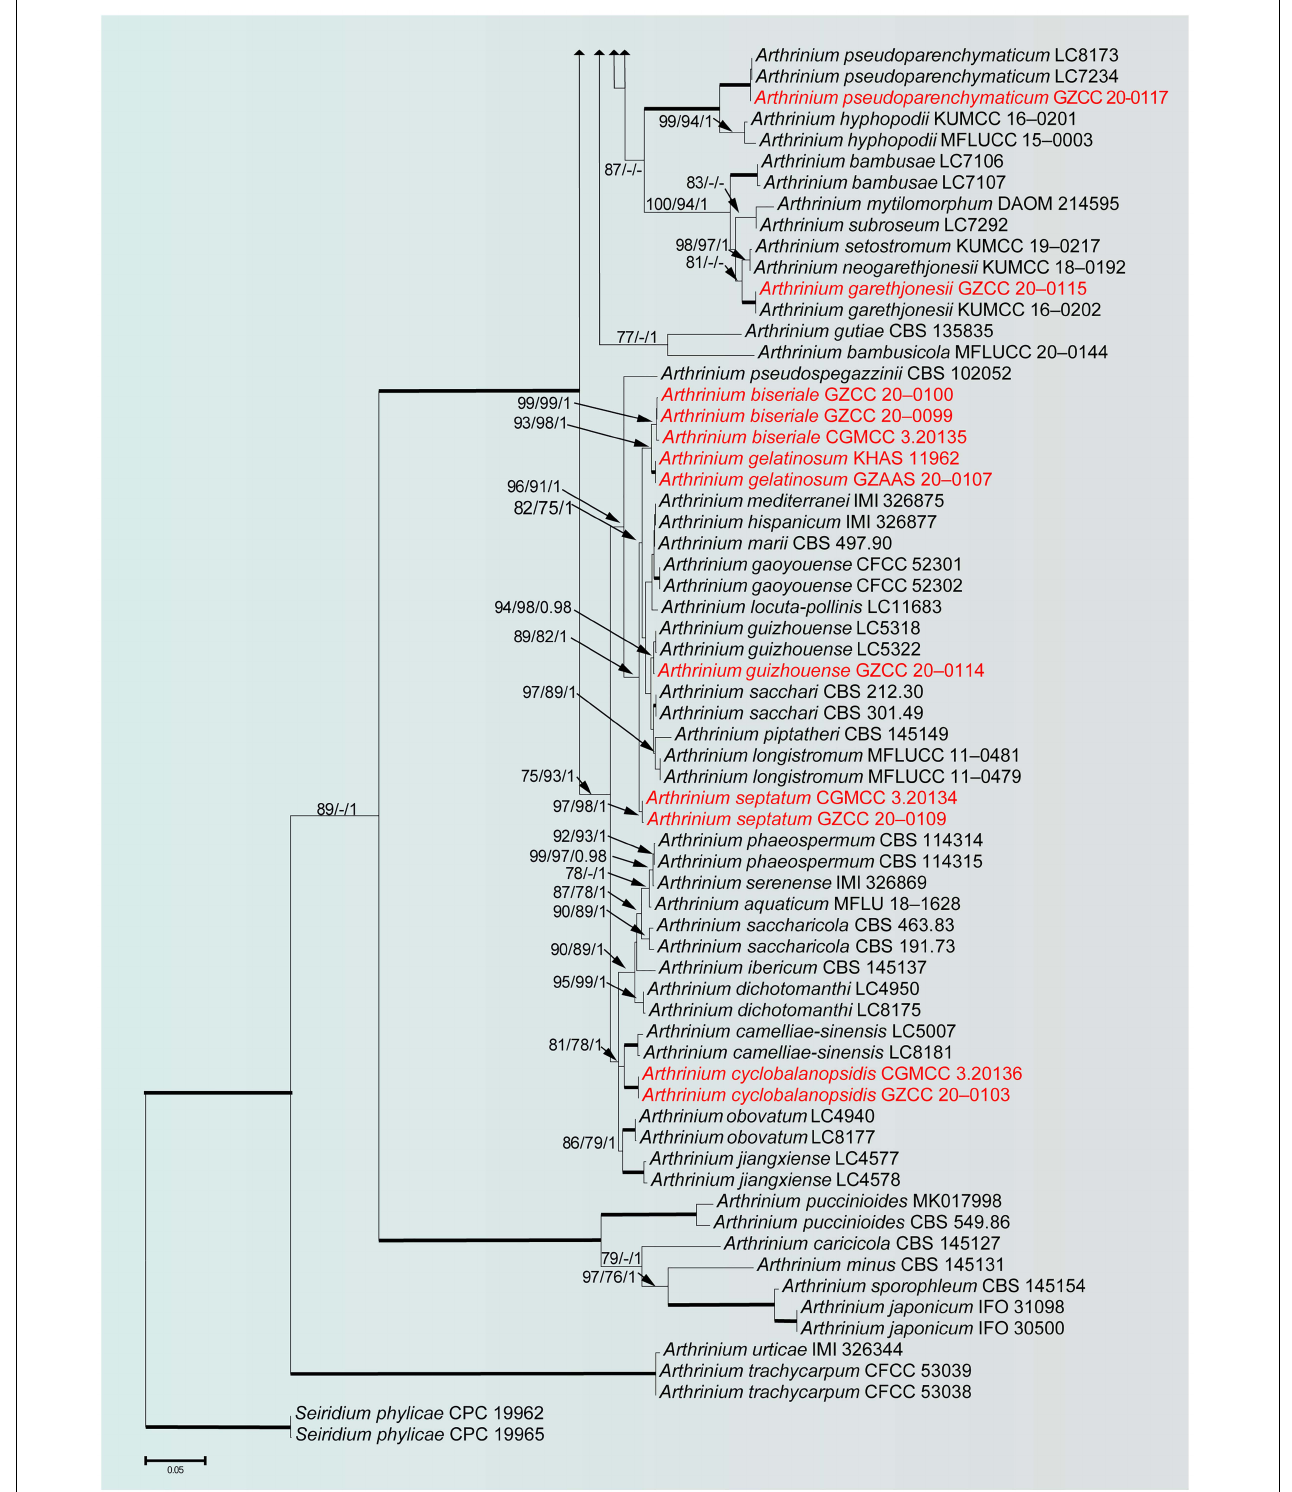
FIGURE 1 | RAxML tree of representatives based on a combined dataset of ITS, LSU, TUB2 and TEF sequences. Bootstrap support values for ML, MP ( ≥ 75%) and Bayesian ( ≥ 0.95) are given at the nodes (ML/MP/BI). Branches with ML, MP and BI equal 100, 100 and 1 are in bold. The tree is rooted with Seiridium phylicae (CPC 19962 and CPC 19965). New strains are shown in